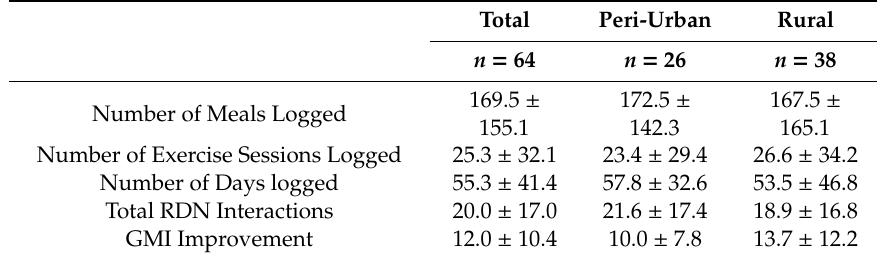
Table 2. Good Measures (GM) application usage.